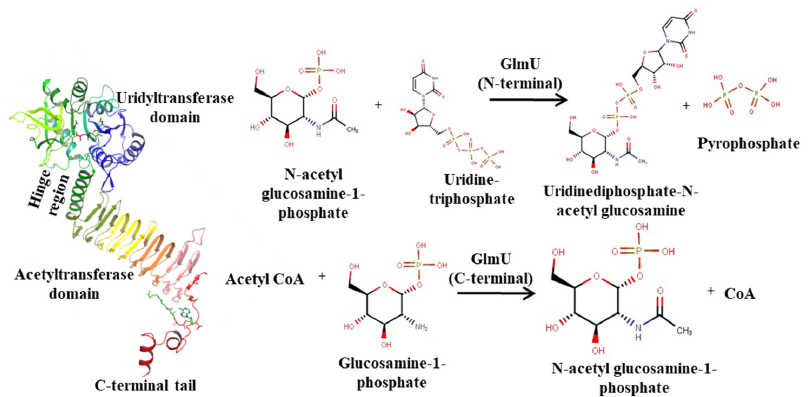
Figure 1. GlmU structure and its reactions. Acetyltransferase reaction catalyzed by C-terminal acetyltransferase domain. Uridyl transferase reaction catalyzed by N-terminal uridyltransferase domain.